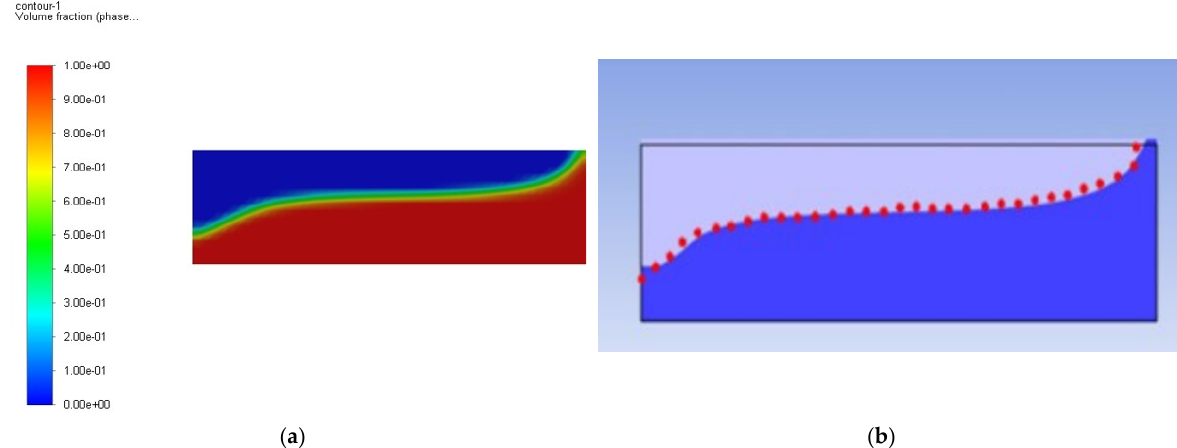
Figure 4. Comparison of Bounded 2nd order time discretization between: ( a ) Present study, ( b ) Numerical data [30], and experimental data [33], (red dotted line).